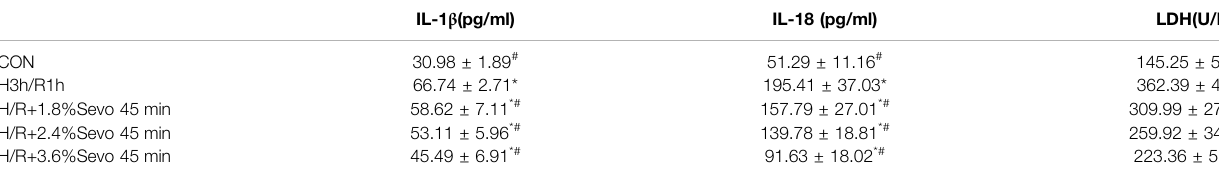
TABLE 5 | Effects of Sevo fl urane at different concentrations on the release of IL-1 β , IL-18 and LDH in NRVM after H/R (n (cid:1) 3).